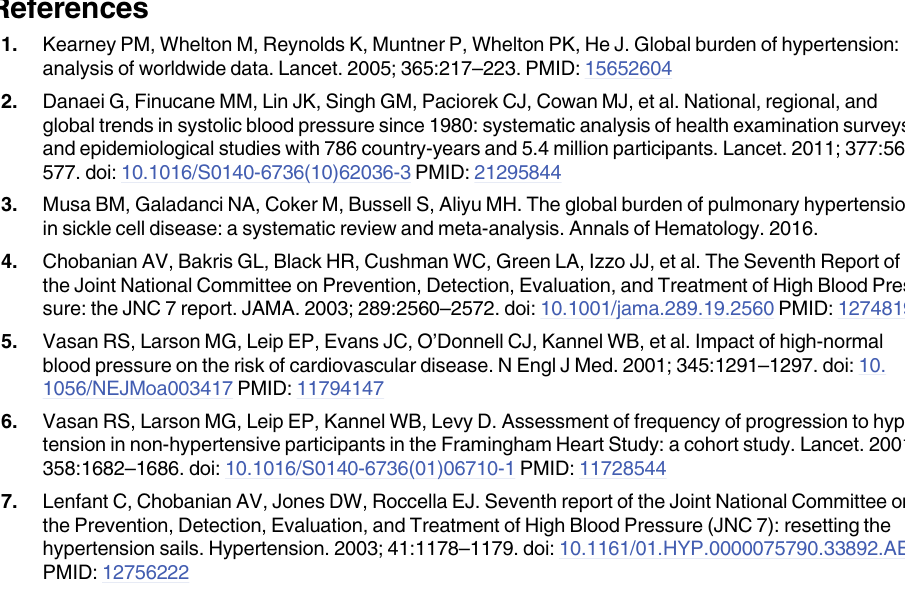
S1 Table. Minimal data